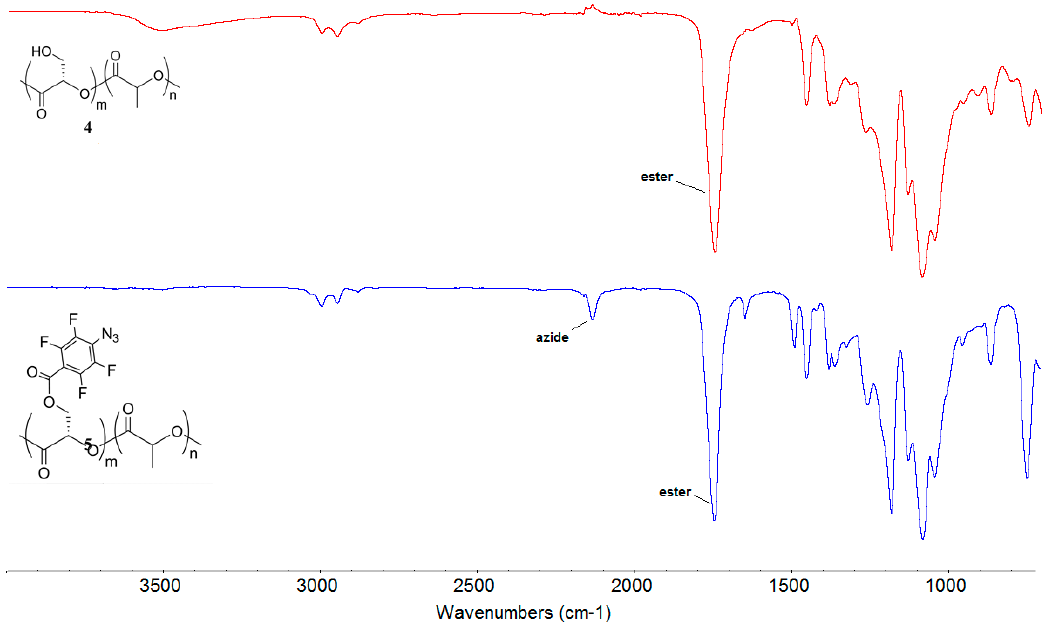
Figure 2. FTIR spectra of PLA copolymers 4 and 5.